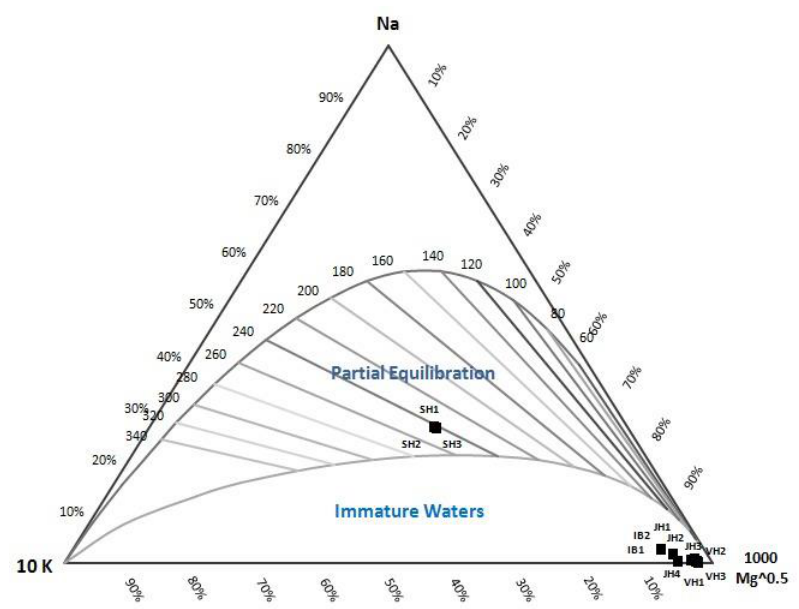
Figure 3. Triangle diagram of Na-K-Mg in Seulawah Agam Mountain Area.